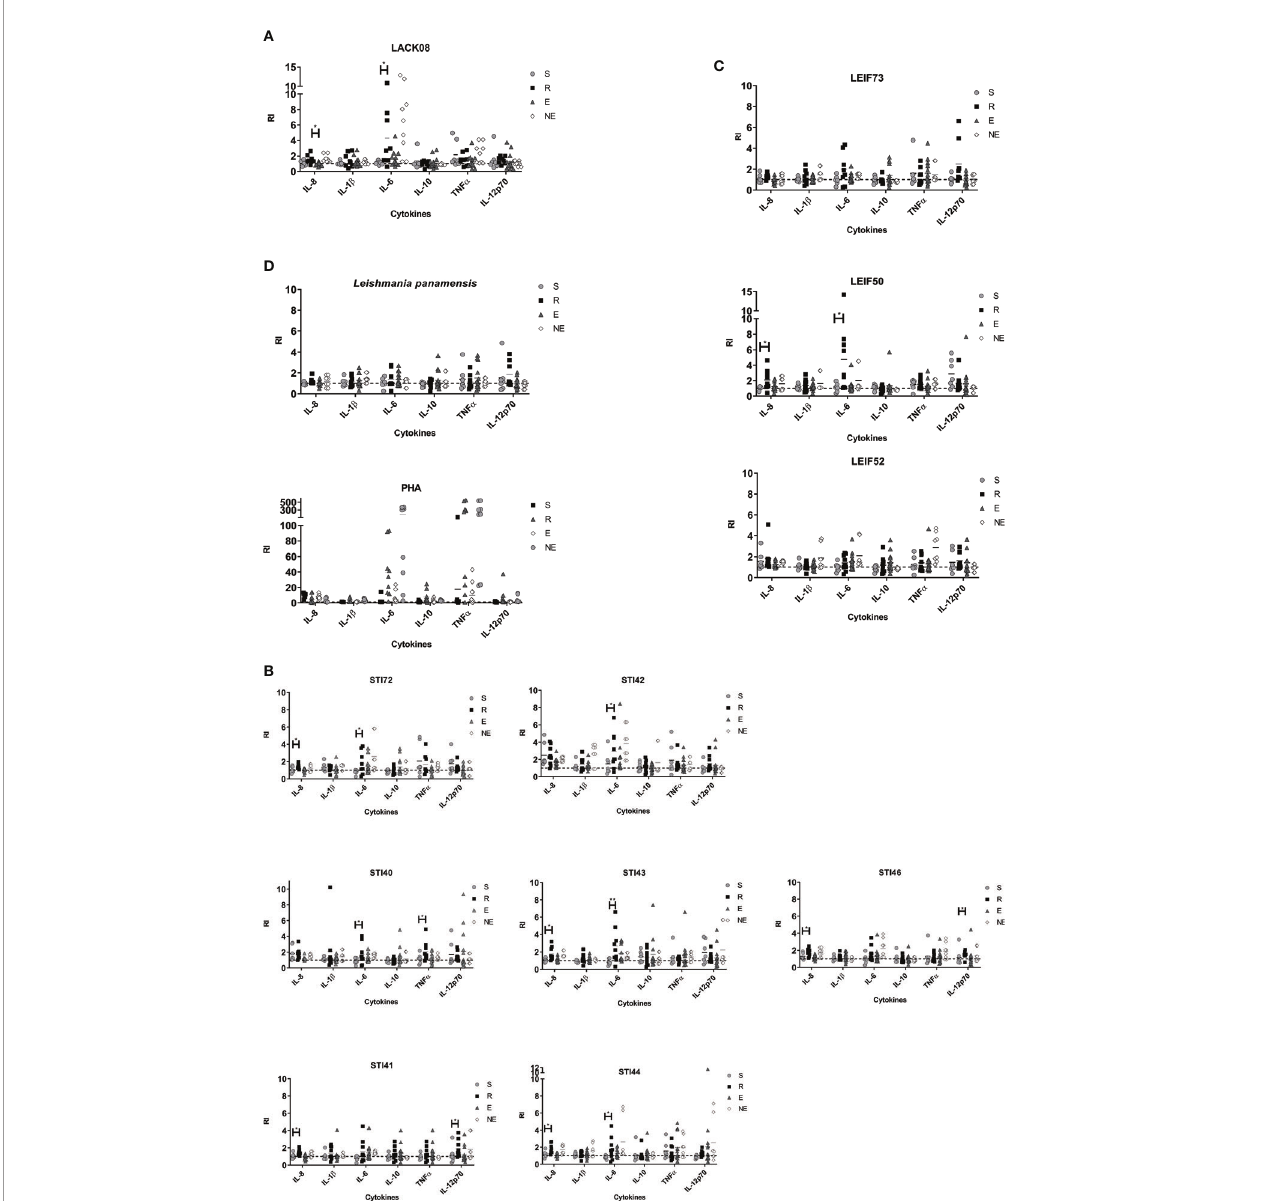
FIGURE 1 | Cytokines detected in human moDCs supernatants from S (susceptible), R (resistant), E (exposed), and NE (not exposed) groups. Cell pulsed with (A) peptides derived from LACK protein; (B) peptides derived from STI1 protein; (C) peptides derived from LEIF, and (D) L. panamensis or PHA. P<0.05(*), P<0.01 (**). Dashed line: non-stimulated cell